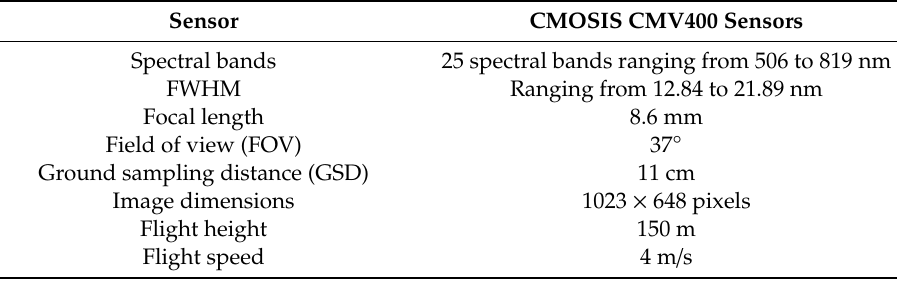
Table 3. Characteristics of the camera, flight, and data acquired in the study